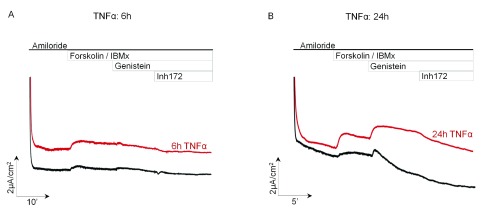
TNFα treatment of primary HBE cells increases CFTR-dependent chloride secretion.Short-circuit current experiments on air-liquid cultures of HBE cells from a F508del/F508del CF patient. Amiloride, an inhibitor of Na
+ current (ENaC), was present throughout the experiment. Forskolin (10µM) + IBMX (100µM) were added apically and basolaterally to increase the intracellular cAMP to activate the cAMP-dependent currents, followed by addition of genistein (50µM), a phytoestrogen known to potentiate I
CFTR. The inhibitor of I
CFTR, inh-172 (10µM), was added to the apical Ussing chamber to attest to the presence of I
CFTR.
A. Treatment of cells for 6h with 50ng/ml of TNFα induced cAMP-dependent, inh172 sensitive chloride current of higher magnitude than control non-treated cells.
B. Treatment of cells for 24h with 50ng/ml of TNFα induced cAMP-dependent chloride current, potentiated by genistein and abolished by inh172 of higher magnitude than control cells. Black tracings represent Isc measurements in control untreated cell cultures whereas red tracings visualize Isc measurements in epithelia treated with TNFα.